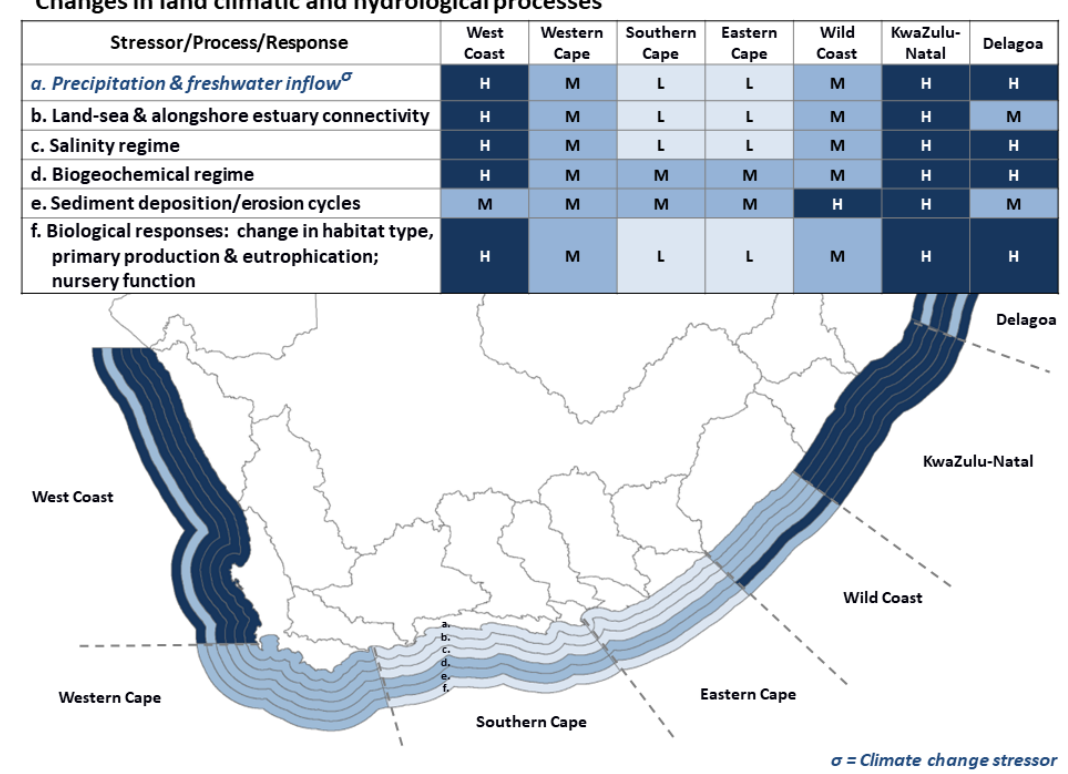
Figure 2. Summary of vulnerability rating (high/medium/low) for estuaries in the seven coastal regions associated with change in land climatic and hydrological processes (colour zones on map depict ( a ) to ( f ) in the table moving outward from the coast with H = high, M = medium, L = low).